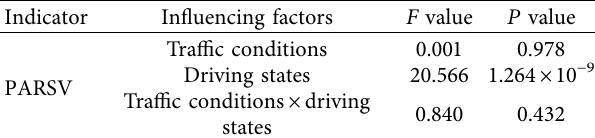
Table 8: Two-way ANOVA of